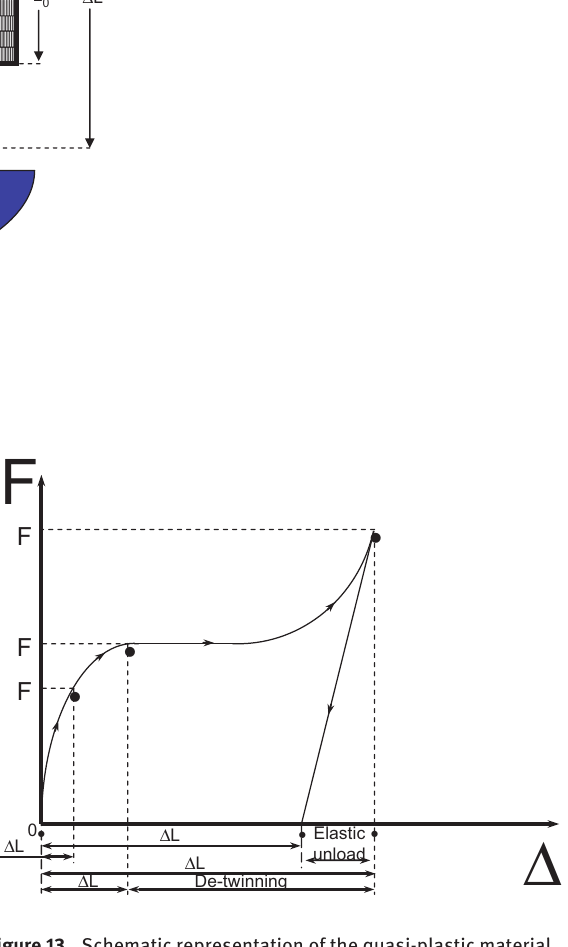
Figure 13 Schematic representation of the quasi-plastic material response exhibited by shape memory